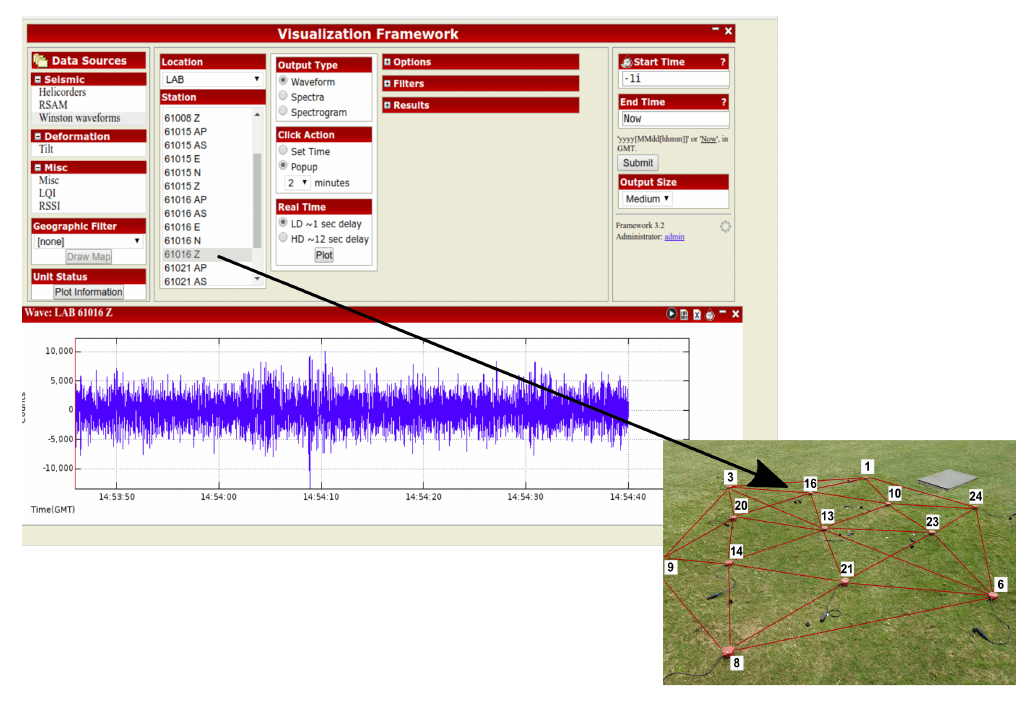
Figure 9. Data visualization. For image purposes, only geophone locations are shown in deployment image.